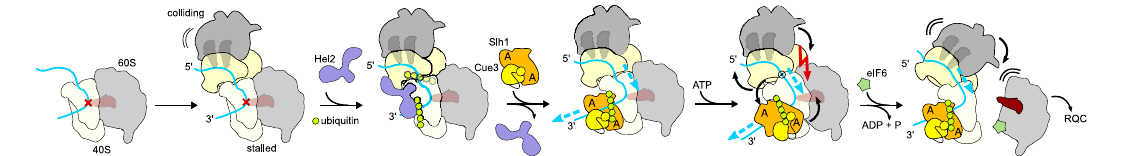
Fig.5|ModelforRQT-mediatedribosomesplittingaftercollision. Afterstalling and subsequent collision of trailing ribosomes, Hel2 recognizes the collision interface and (poly)ubiquitinates uS10. RQT binds polyubiquitinated stalled ribo- somes and engages with accessible 3 ′ -mRNA emerging from the stalled lead ribo- some. A pulling force on the mRNA (blue arrows) may cause head-swiveling, destabilizationoftheleadribosomeandultimatelydrivethetrailingribosomelikea